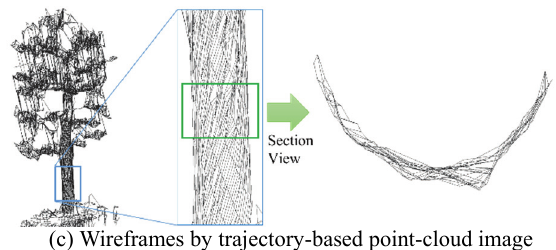
Figure 6 . Comparison of wireframes by generation